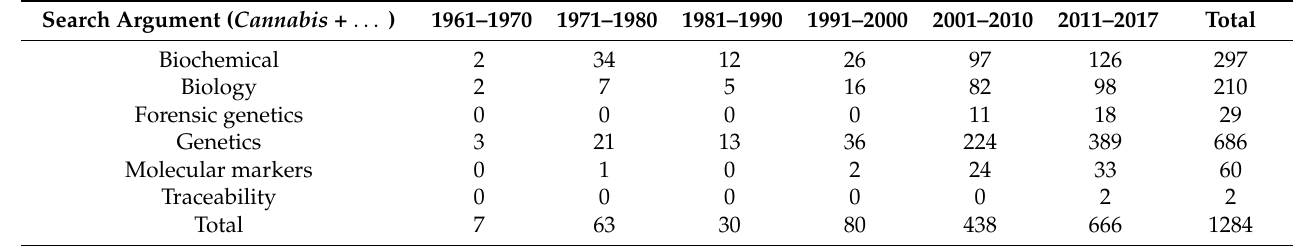
Table 2. Number of publications retrieved from the Scopus platform grouped for decades, according to the search arguments. Search Argument ( Cannabis + . . .